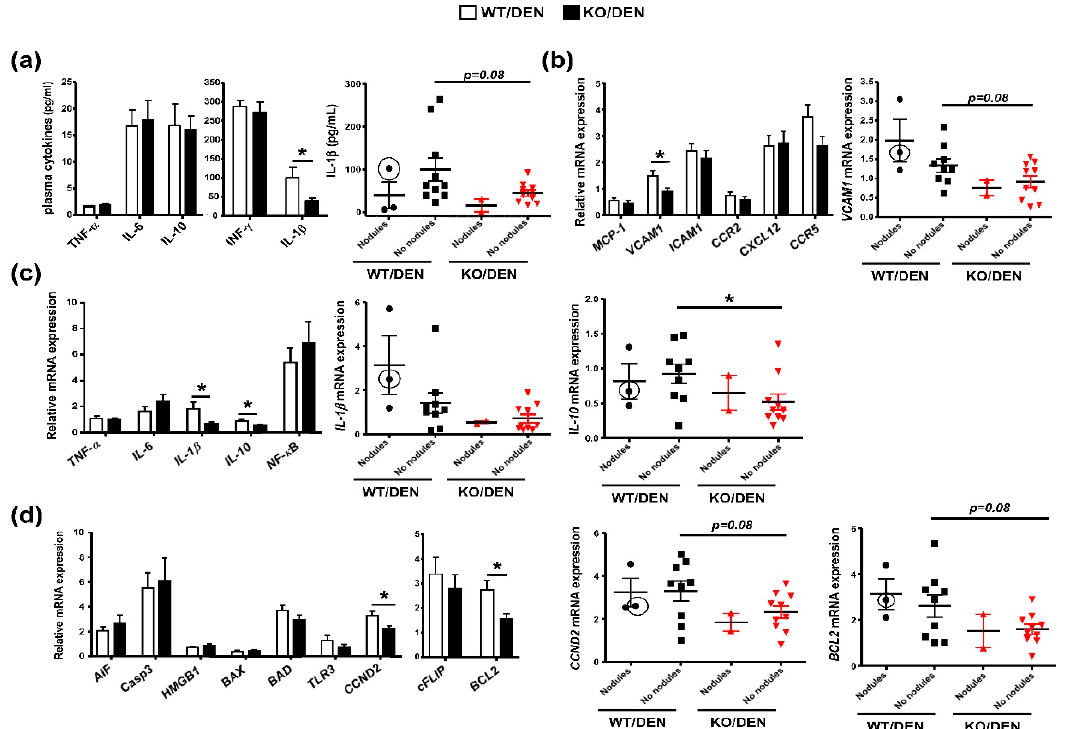
Figure 3. Mice were treated as described in Figure 1. Data in the left-hand panel were obtained from the total number of mice, and those in right-hand panel(s) were obtained from ‘Nodule’ and ‘No-nodule’ groups. ( a ) Plasma levels (pg/mL) of cytokines TNF- α , IL-6, IL-10, IFN- γ , and IL-1 β . ( b ) Hepatic mRNA expression of genes related to chemokines ( MCP-1 , VCAM1 , ICAM1 , CCR2 , CXCL12 , and CCR5 ). ( c ) Hepatic mRNA expression of inflammatory genes ( TNF- α , IL-6 , IL-1 β , IL-10 , and NF-kB ). ( d ) Hepatic mRNA expression of genes related to apoptosis (inducing factor ( AIF ), caspase3 [ Casp3 ], high-mobility group box1 [ HMGB1 ], BAX , BAD , and TLR3 ) as well as proliferation and anti-apoptosis (cyclin D2 [ CCND2 ], cFLIP , and BCL2 ). The value with a black circle was from DEN-treated WT Mouse #8. Data are mean ± SEM; N = 12–13. * p < 0.05 with Mann-Whitney U tests for total number of mice, and t -tests ( p = 0.08) with Welch’s correction for mice with or without nodules ( p < 0.1 considered